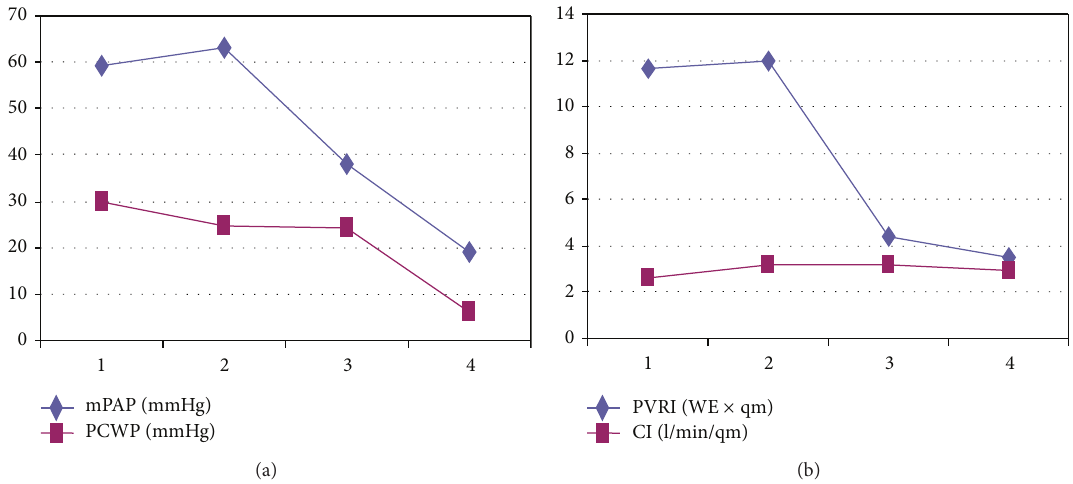
Figure3:Hemodynamicmeasurementsbeforeandafterhearttransplantation.Meanpulmonaryarterypressure(mPAP)pulmonarycapillary wedge pressure (PCWP) (a). Pulmonary vascular resistance index (PVRI) and cardiac index (CI) (b). Time course before (1) and after levosimendan (2), with bosentan/epoprostenol (3) and after heart transplantation (4).